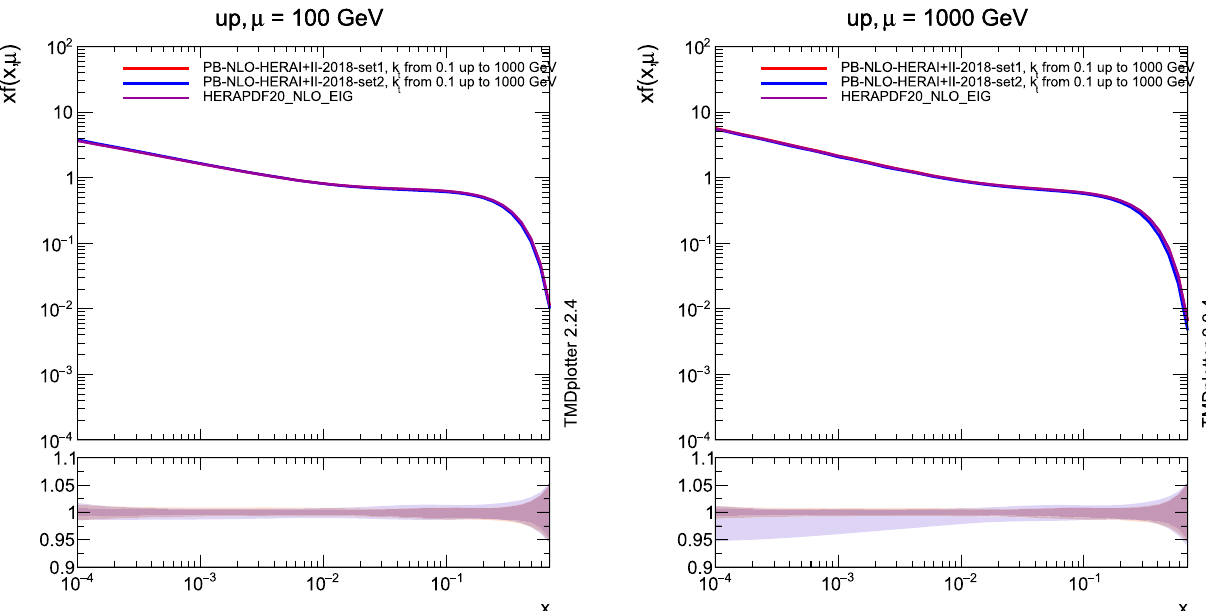
Fig. 1 Collinear parton density distributions for up quarks (PB-NLO-2018-Set 1, PB-NLO-2018-Set 2 and HERAPDF2.0) as a function of x at μ = 100 and 1000 GeV. In the lower panel the uncertainties are shown